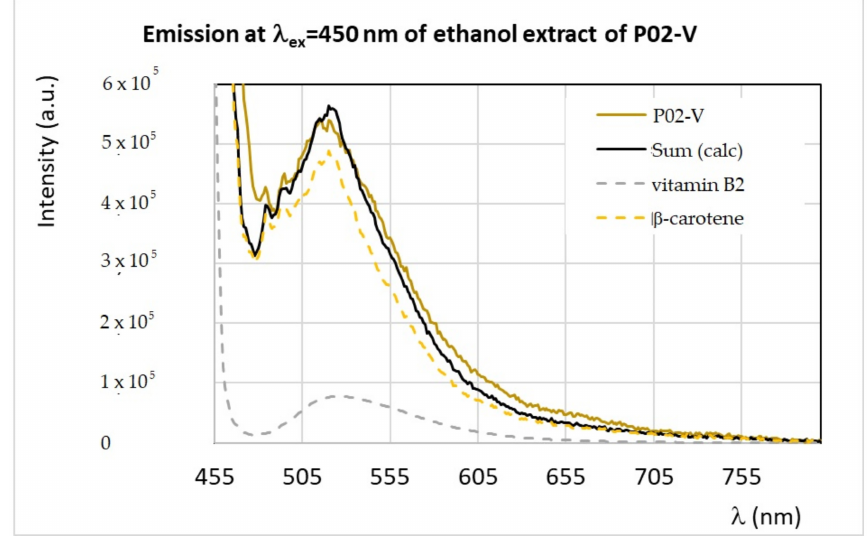
Figure 6. Experimental and calculated FFF emission spectra of the ethanol extracts obtained from the samples P02-V, prepared as described in the main text, obtained by exciting the sample at λ ex = 450 nm. The calculated spectrum, indicated as Sum (calc), is obtained as the sum of di ff erent components: vitamin B 2 (riboflavin) and β